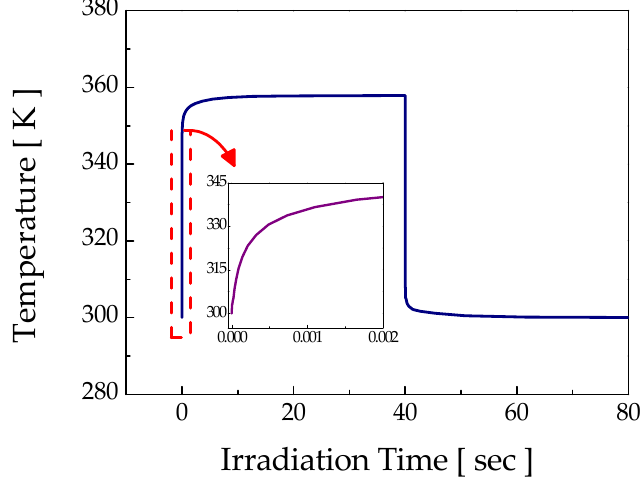
Figure 4. Workpiece surface temperature variation at the threshold etch condition.